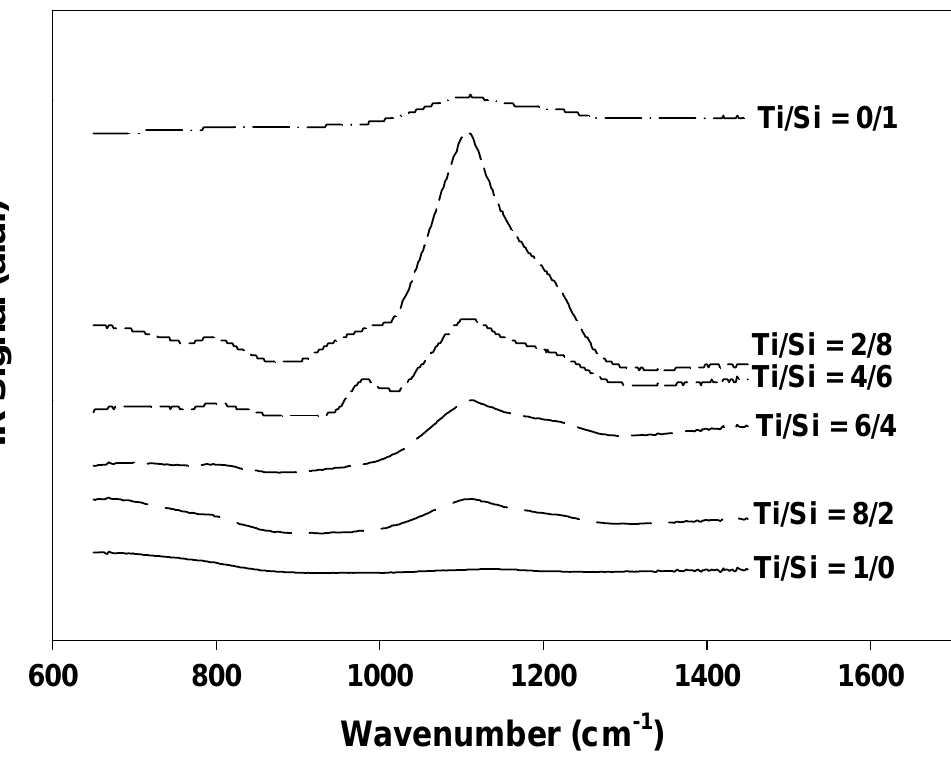
Figure 2. IR spectra of titania/silica mixed oxide